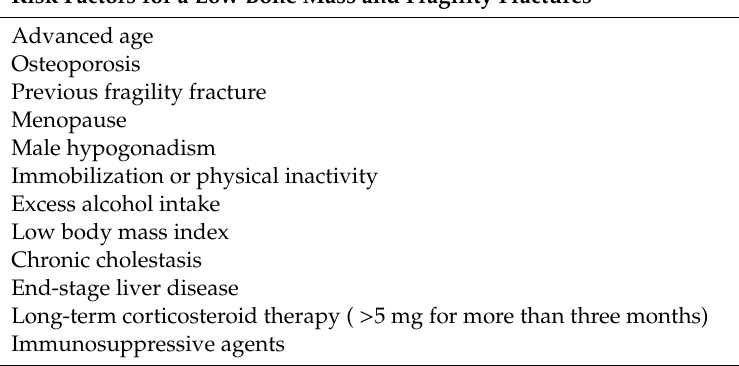
Table 3. Risk factors for a low bone